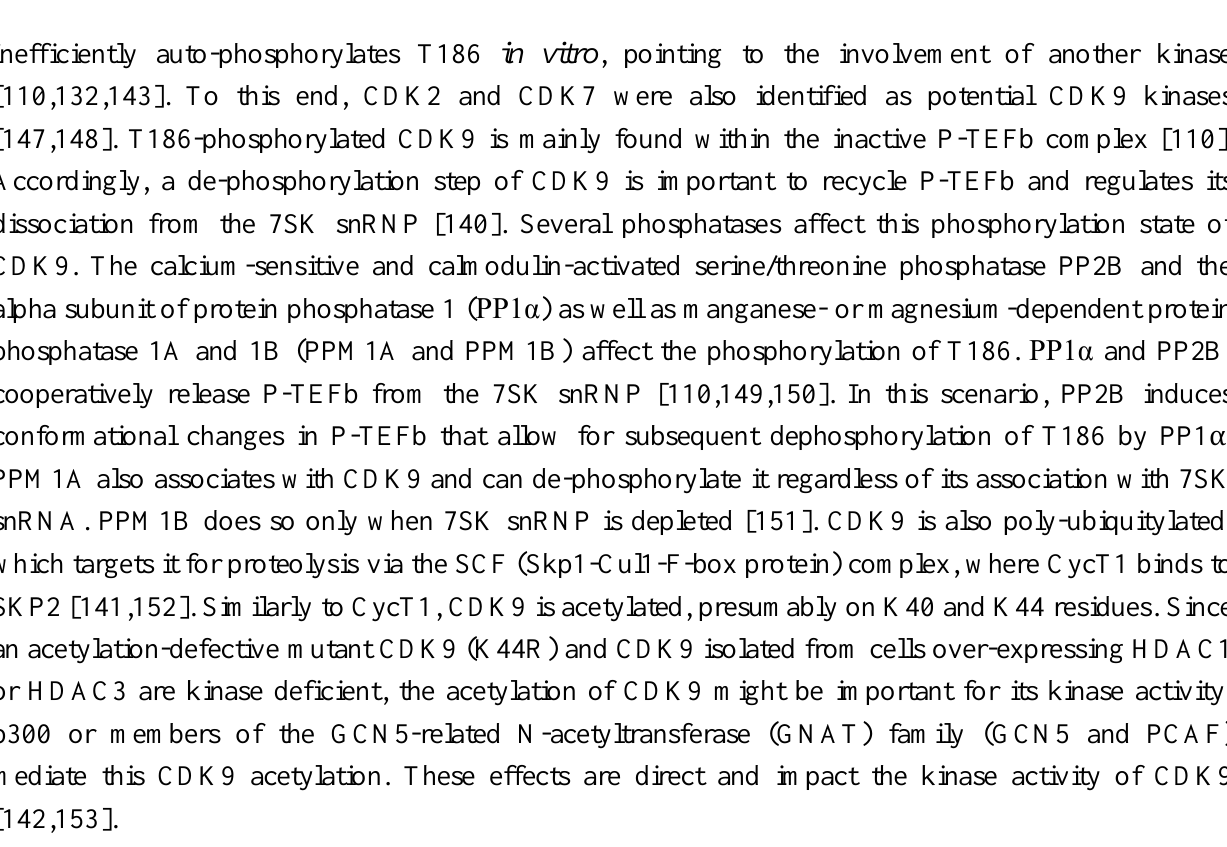
Figure 4: Recruitment mechanisms of P-TEFb to promoter . The efficient transcription of signal-inducible genes relies on the release of P-TEFb from its inactive complex and also on its recruitment to promoters. Recruitment of P-TEFb to viral and host promoters leads to stimulation of transcription, thus releasing RNAPII from pausing. Several pathways exist for the recruitment of P-TEFb to the HIV LTR. Among them, Tat- independent basal transcription includes recruitment via NF  B, Brd4 and SEC in the Mediator. Elongation of transcription is enhanced by Tat, which binds P-TEFb and tethers it to